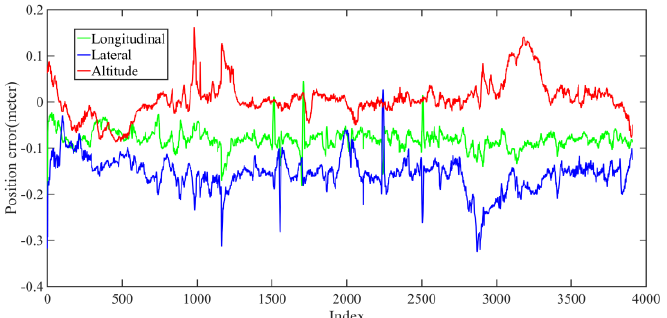
Figure 9. The comparison of fused trajectory and groundtruth. The fused localization data basically coincides with the groundtruth, indicating that the online localization results meet expectations.